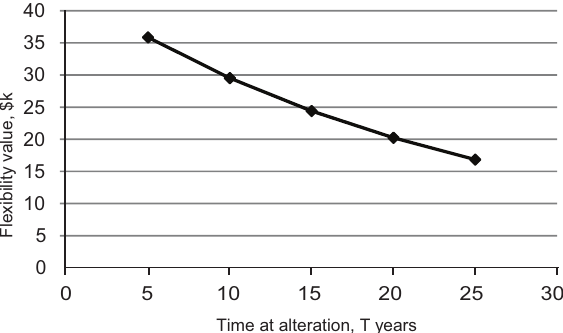
Figure 2. Case example – change in flexibility value with time at alteration, T. r = 0.05 per annum